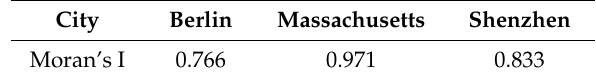
Table A1. Moran’s I of the coarse nighttime light images in the study